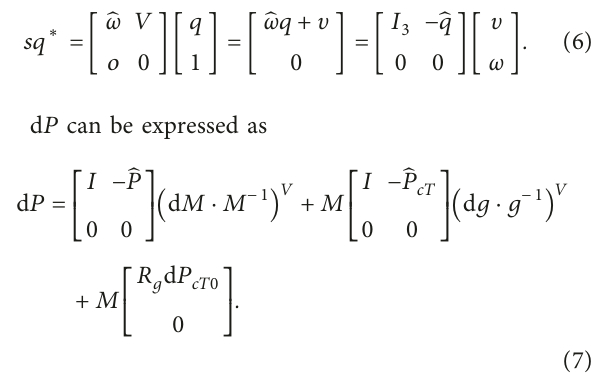
Figure 1: Structure of 6R SIASUN SR210D manipulator. Table 1: Nominal value of robot structure parameters. L i , i � 1–5